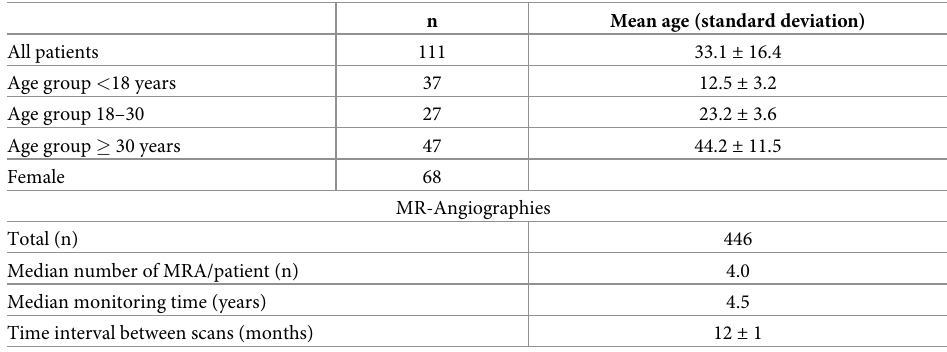
Table 1. Demographics and MR-angiography